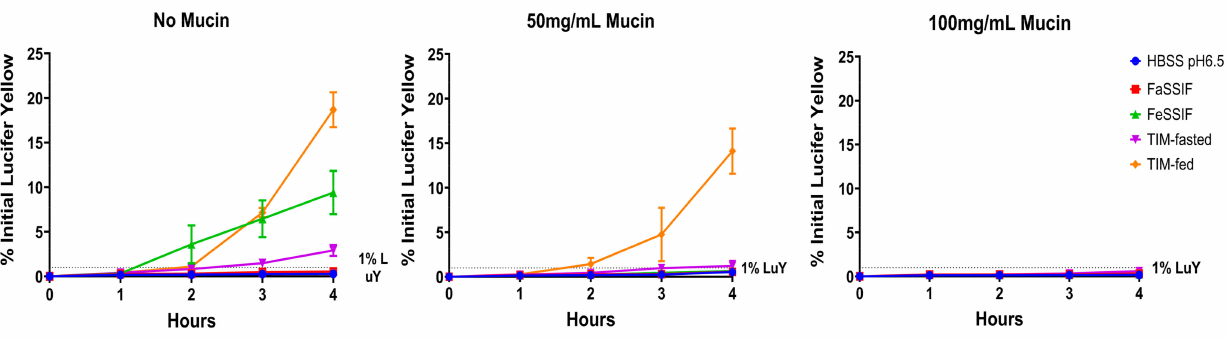
Figure 2. Porcine type III mucin maintains Caco-2 monolayer integrity in concentration dependence during the applications of fasted and fed state SIFs and TIM media. The % LuY permeation was measured over 4 h following the treatment of HBSS pH 6.5, FaSSIF, FeSSIF, TIM-fasted and TIM-fed media in the Caco-2 together with 0, 50 and 100 mg/mL of